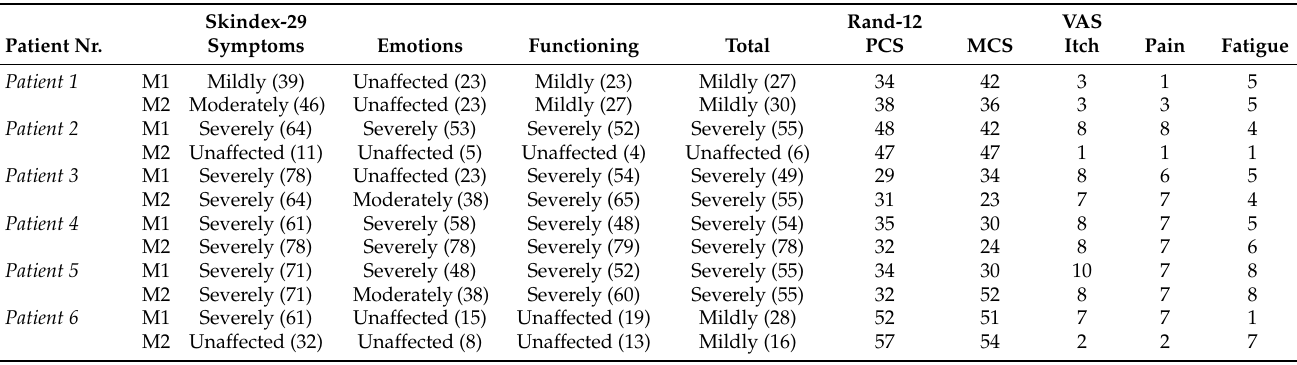
Table 4. Skindex-29, RAND-12, and itch, pain, and fatigue VAS scores at the start and end of the study period including median